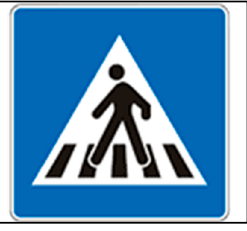
Figure 3. The traffic sign “Pedestrian crossing” (III-6).